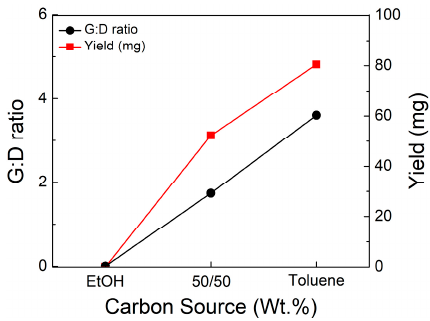
Figure 12. Plot of the Raman G:D ratio (black) and product yield (red) for DLICVD experiments with the carbon source consisting of varying degrees of toluene in EtOH. Experiments were performed with an aspiration temperature of 225 °C, a reaction temperature of 800 °C, an injection rate of 1 mL/h, and a 5.00 wt.% catalyst concentration.